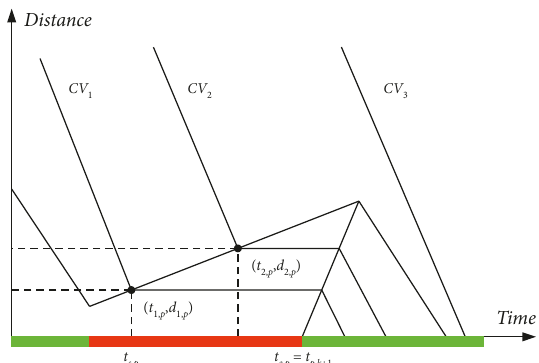
Figure 2: Illustration of vehicle informatio V